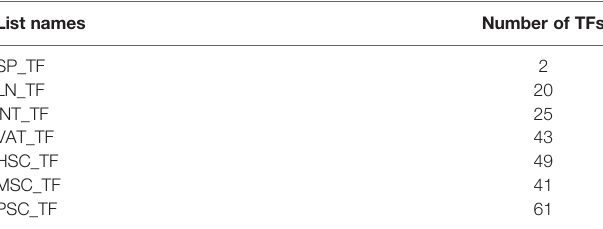
TABLE 13 | The transcription factor (TF) genes identi fi ed in tissue Treg and stem cells were summarized.